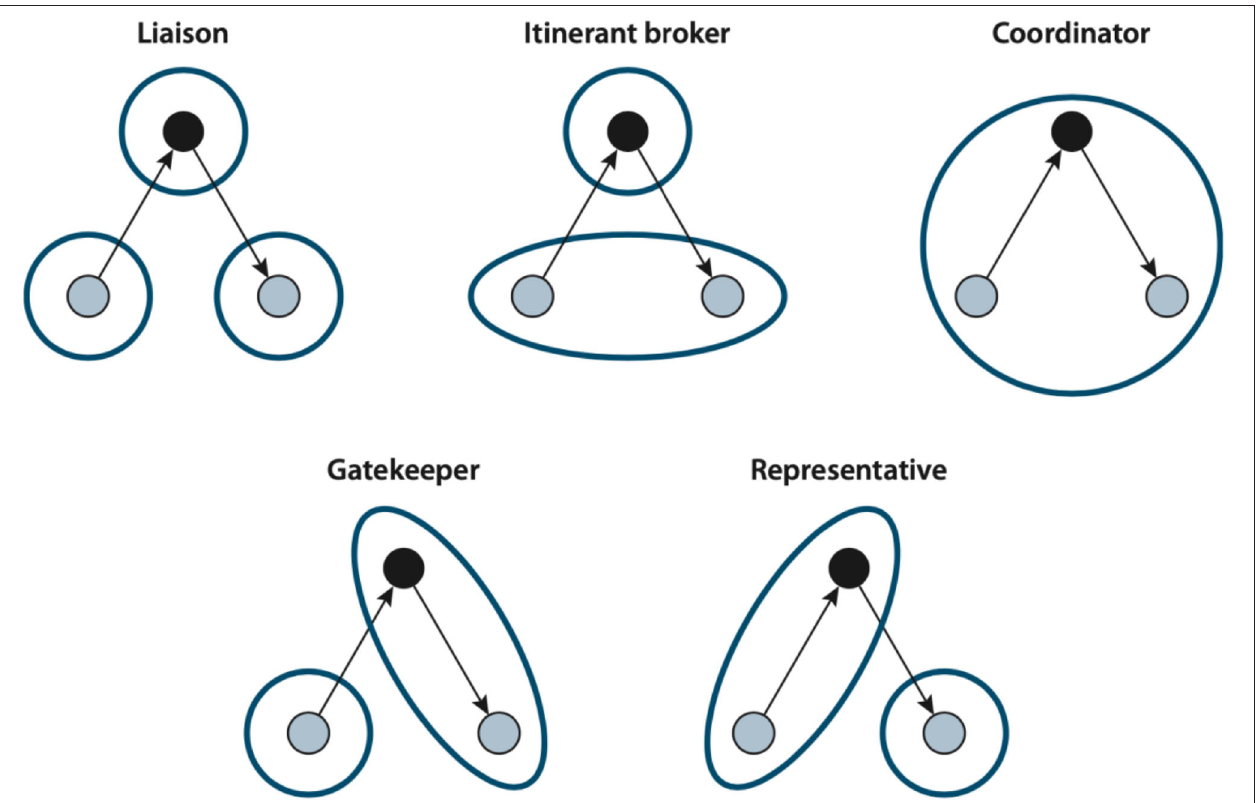
FIGURE 1 | Types of brokerage relevant to conservation crime and wildlife rangers. Adapted with permission from Stovel and Shaw (2012). The black dot represents the broker, the circles represent subgroups, and the arrows represent the direction of information and resources.